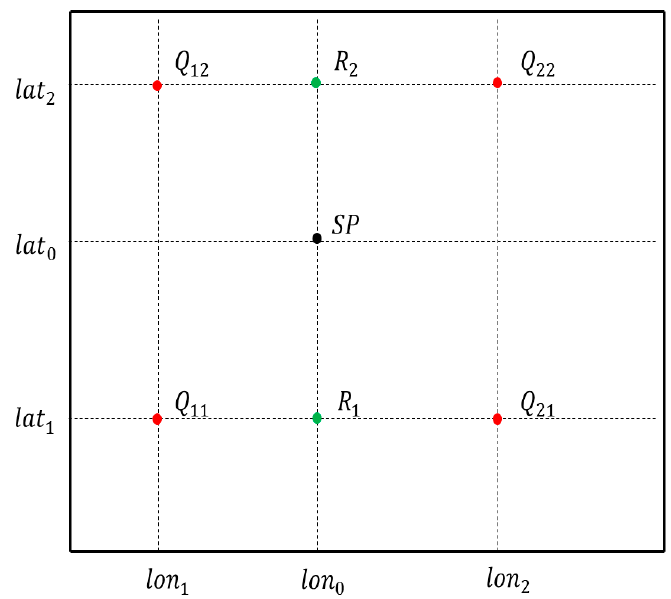
Figure 4. Bilinear interpolation schematic.